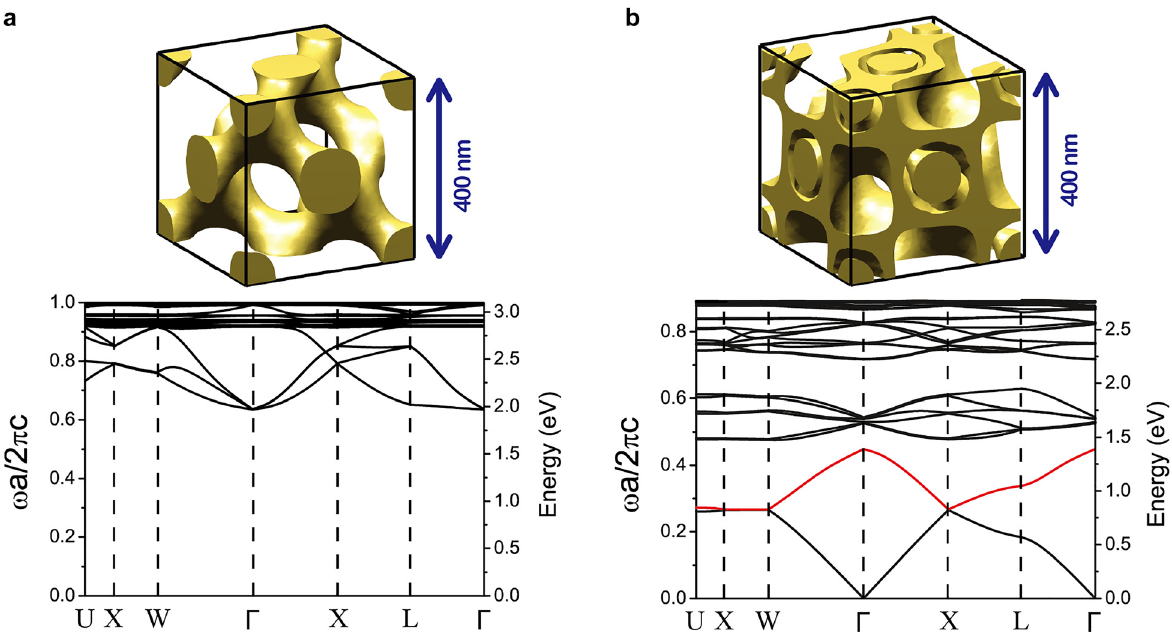
Figure 15: Photonic band structures of 3D continuous diamond cubic metamaterials, space group Q 227 ( Fd 3 m ). (a) Metamaterial with no internal substructure and (b) metamaterial with a metal/insulator/metal coaxial substructure. Red line represents negative refraction band.